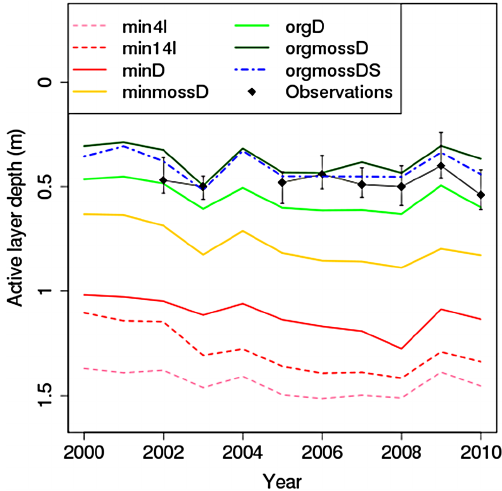
Figure 5. Simulated active layer depth at Samoylov since 2000. Ob- servations show the mean thaw depth from polygon centre active- layer monitoring points (see Fig. 3), with error bars indicating the range of measured values. Simulations begin with the standard four- layer JULES (min4l), and improvements are systematically added: higher-resolution soil (min14l), deeper soil (minD), moss cover (minmossD), organic soils (orgD, orgmossD), and the improved snow scheme